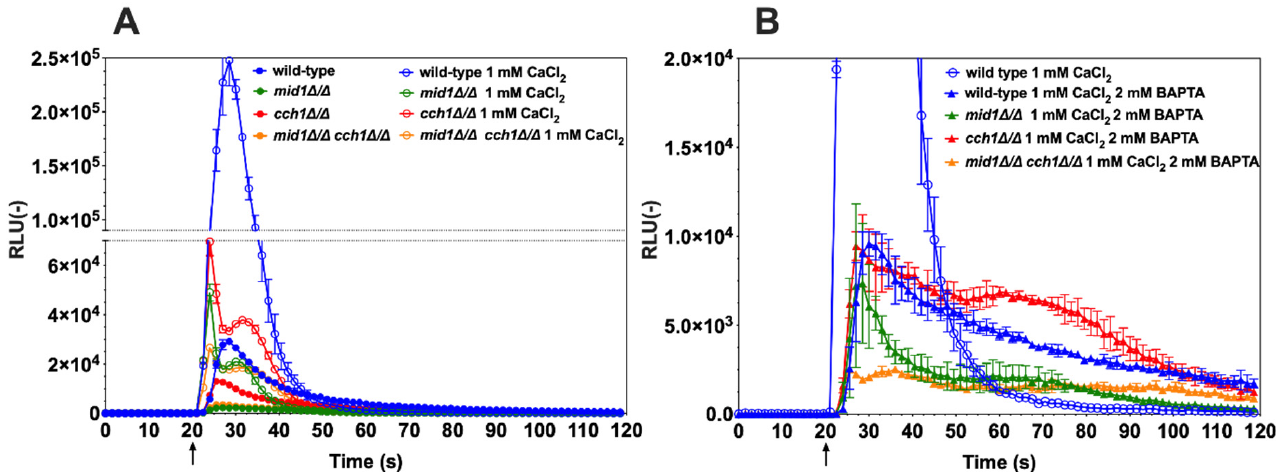
Figure 4. Amiodarone perturbs Ca 2+ homeostasis in C. albicans . Wild-type (DSY4730, DSY4726, DSY4727 and DSY4729), mid1 ∆ / ∆ , cch1 ∆ / ∆ and mid1 ∆ / ∆ cch1 ∆ / ∆ cells were prepared as described in the Materials and Methods. Injection of amiodarone was performed after 20 s of pre-incubation in GLAC medium (arrow). ( A ) Effect of the addition of CaCl 2 (1 mM). Comparisons of RLU values between the absence and presence of CaCl 2 in the amiodarone-treated wild-type and mutants were all significant ( p < 0.001) after injections and up to 45 s of experiment time had elapsed. Comparisons of RLU values in the presence of CaCl 2 and amiodarone between wild-type and mutants were all significant ( p < 0.001). Comparisons of RLU values in the presence of CaCl 2 and amiodarone between mutants were all significant ( p < 0.001), with the exception between the mid1 ∆ / ∆ and mid1 ∆ / ∆ cch1 ∆ / ∆ mutants. ( B ) Effect of the addition of CaCl 2 (1 mM) and BAPTA (2 mM), added before the start of the experiment. Results were obtained from duplicate experiments and data were subtracted from background cells devoid of aequorin expression (SC5314). A recapitulation of a CaCl 2 -only condition (panel A) is given for the wild-type comparison. Comparisons of RLU values between the presence of CaCl 2 and BAPTA chelation in the amiodarone-treated wild-type and mutants were all significant ( p < 0.001) after injections and up to 45 s of experiment time had elapsed. Comparisons of RLU values in the presence of CaCl 2 and BAPTA chelation in amiodarone-treated conditions between wild-type and mutants were all significant ( p < 0.001) with the exception of the comparison between wild-type and the cch1 ∆ / ∆ mutant. Comparisons of RLU values in the presence of CaCl 2 and BAPTA chelation in amiodarone-treated conditions between mutants were all significant ( p < 0.001) but not between the mid1 ∆ / ∆ cch1 ∆ / ∆ and mid1 ∆ / ∆ mutant after 35 s of experiment time laps. Data in the y -axis are shown at a lower scale as compared to panel